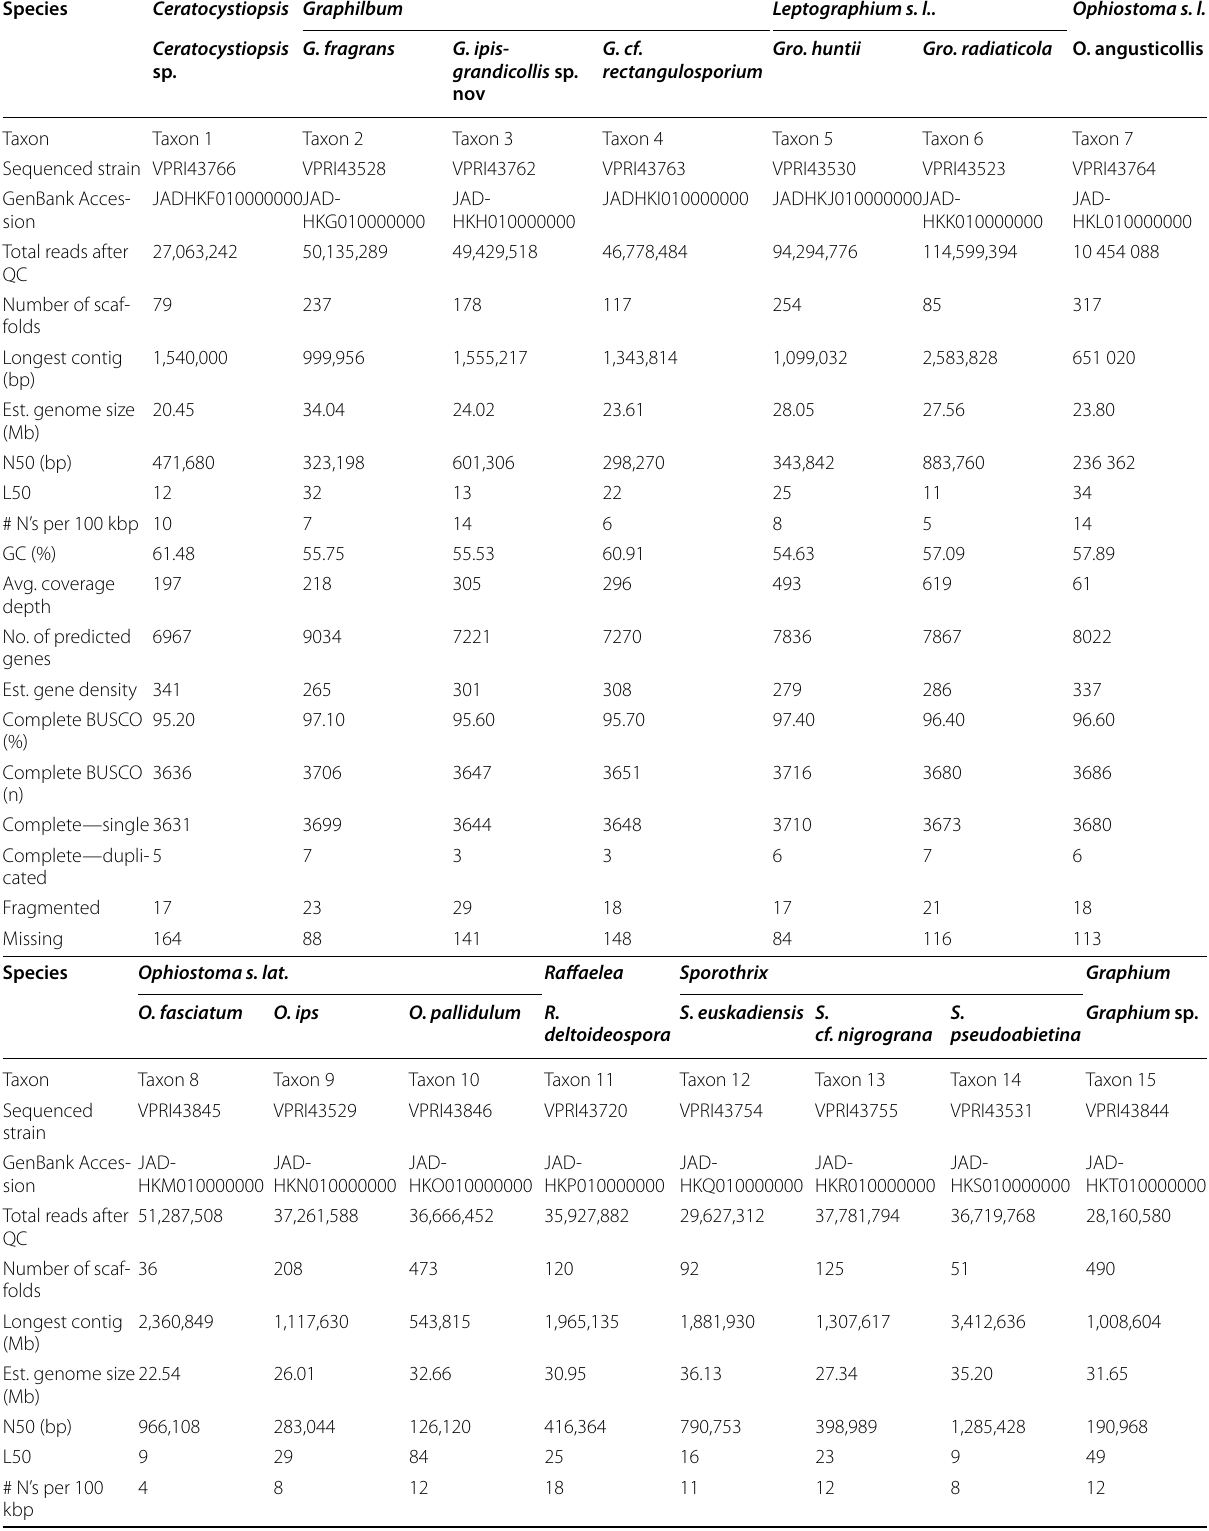
Table 3 Genome summary statistics of representative ophiostomatoid isolates sequenced in this study